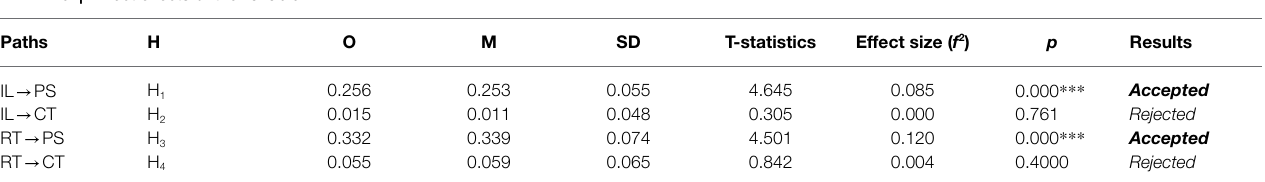
TABLE 6 | Direct effects of the